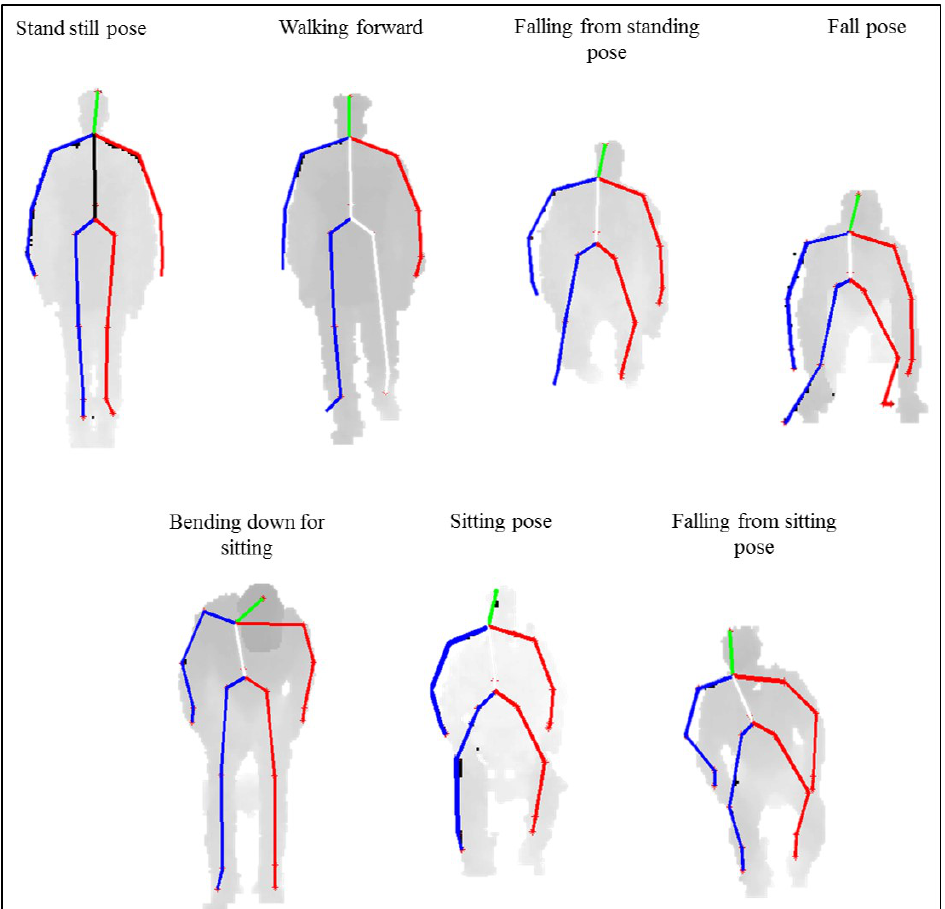
Figure 2. Sample images of different sub-activities associated with the four fall-related activities investigated in this